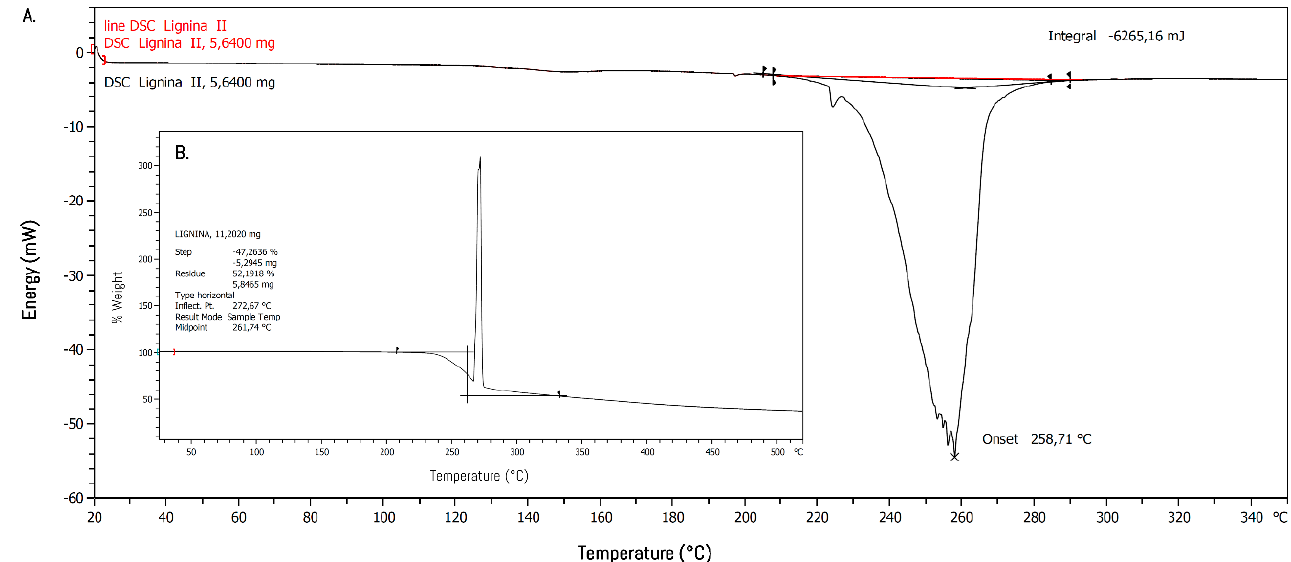
Figure 3. TGA/DSC thermogram of the obtained lignin-based co-polymer. The figure shows the DSC ( A ) and TGA spectrum ( B ) of the synthetized co-polymer.